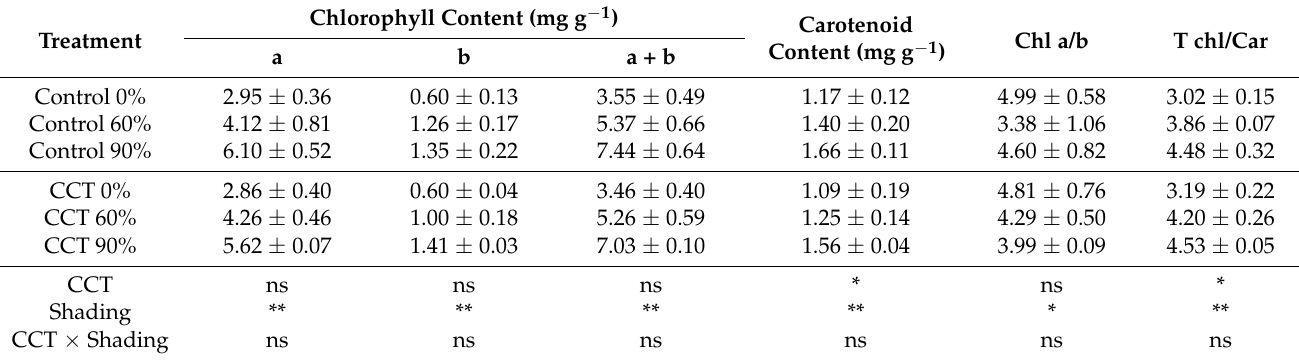
Figure 6. Effects of shading level on PI ABS ( a ) and DF ABS ( b ) of Sedirea japonica under control (CO 2 = 400 ppm) and CCT (climate change treatment, CO 2 = 650 ppm, temperature = control + 3 ◦ C) conditions. Vertical bars are mean ± SD ( n = 5). The asterisk indicates significance at p < 0.05. Table 1. Effects of shading level on chlorophyll and carotenoid contents of Sedirea japonica under control (CO 2 = 400 ppm) and CCT (climate change treatment, CO 2 = 650 ppm, temperature = control + 3 ◦ C)